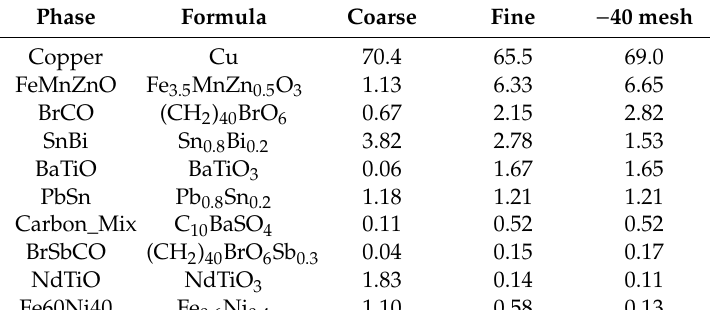
Table 6. Selected phase concentrations of the concentrated shredded printed circuit boards.